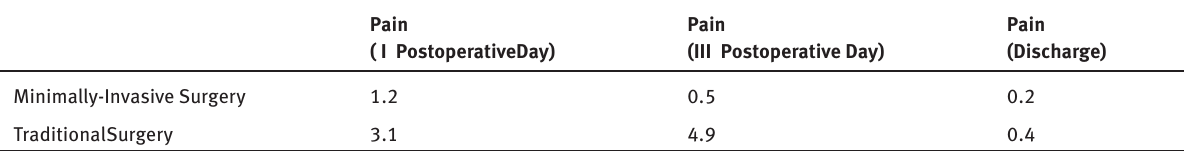
Table 2.1: Mean value of postoperative pain